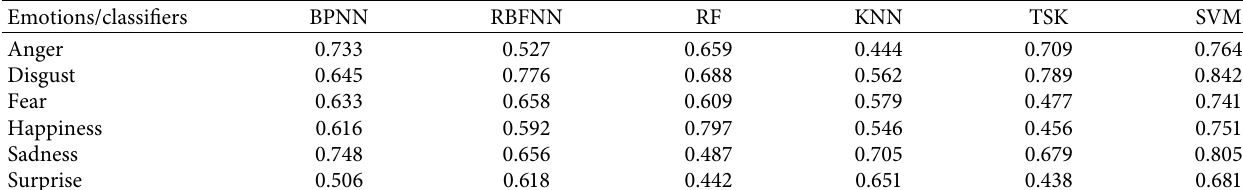
Table 3: Experimental results of emotion recognition based on body movements.